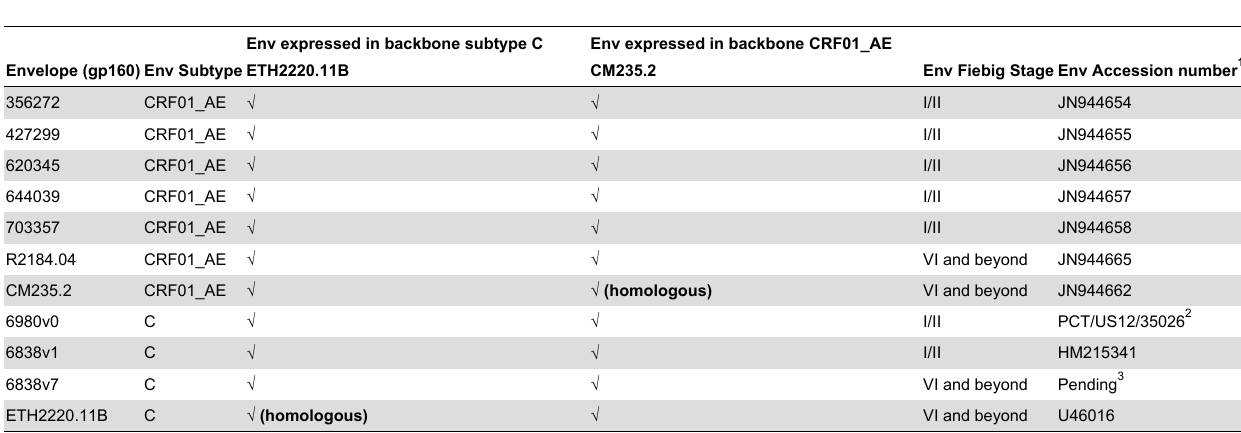
Table 1. List of subtype C and CRF01_AE chimeric